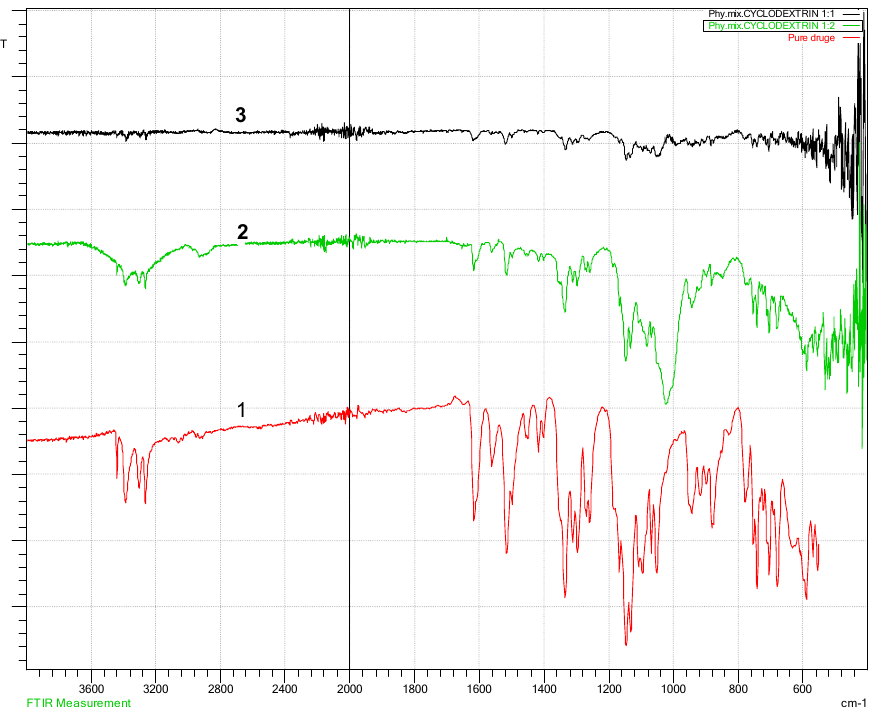
Figure 4. Drug-cyclodextrin Fourier Transform Infra-Red spectroscopy (FT-IR) showing no change on peak locations, but there is a significant change on peak intensities. 1 (red colour): Pure bendroflumethiazide; 2 (green colour): Drug: cyclodextrin 1:2; 3 (black colour): Drug: cyclodextrin 1:1. Pharmaceutics 2018 , 10 , x FOR PEER REVIEW